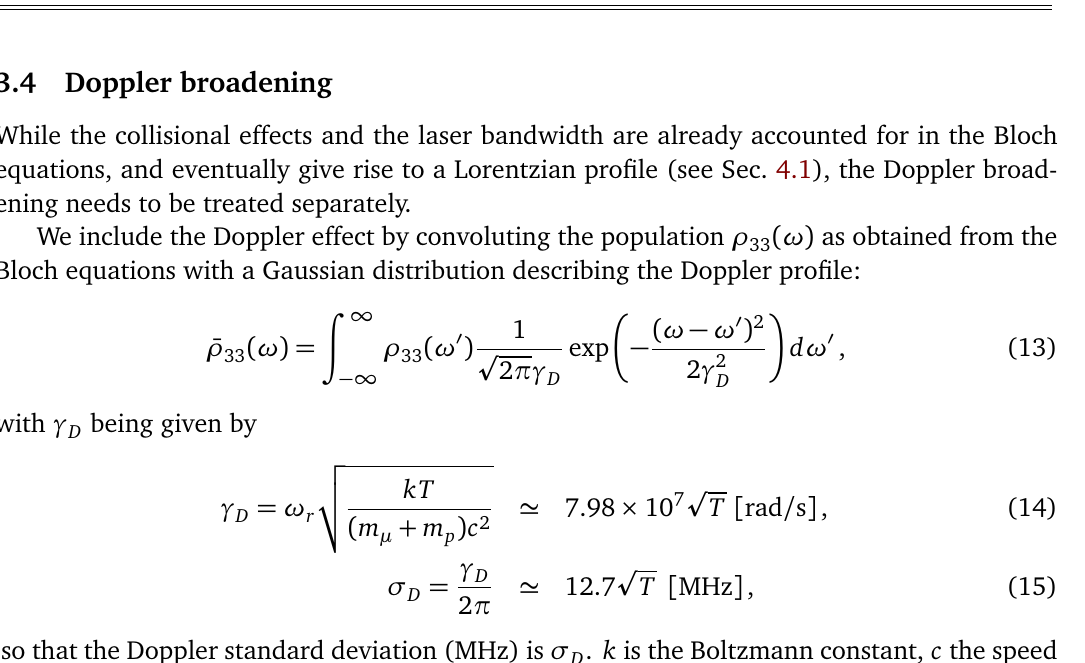
∆ → 10 = 10 MHz ( l ) and sat l F = ω / 2 π for the three r r have been obtained using equa- c is the Doppler D